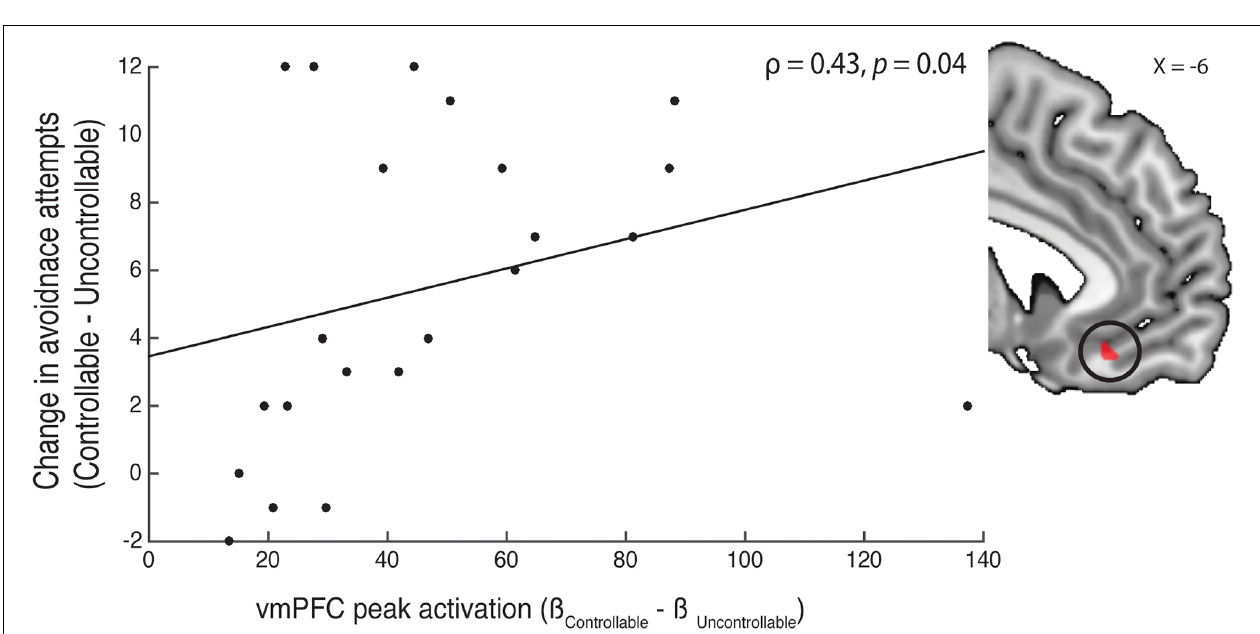
FIGURE 3 | Neural correlates for uncontrollable cues. To examine differences in neural activation between the uncontrollable and controllable phases, we conducted a GLM contrasting the uncontrollable—controllable trials. We observed activity in the amygdala, insula, cingulate cortex and caudate after correcting for multiple comparisons.